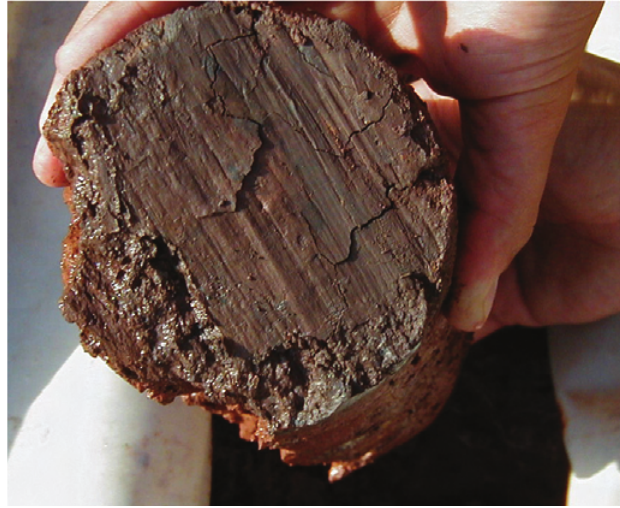
Figure 2. Slip lines observed on the slip surface of the Corinth